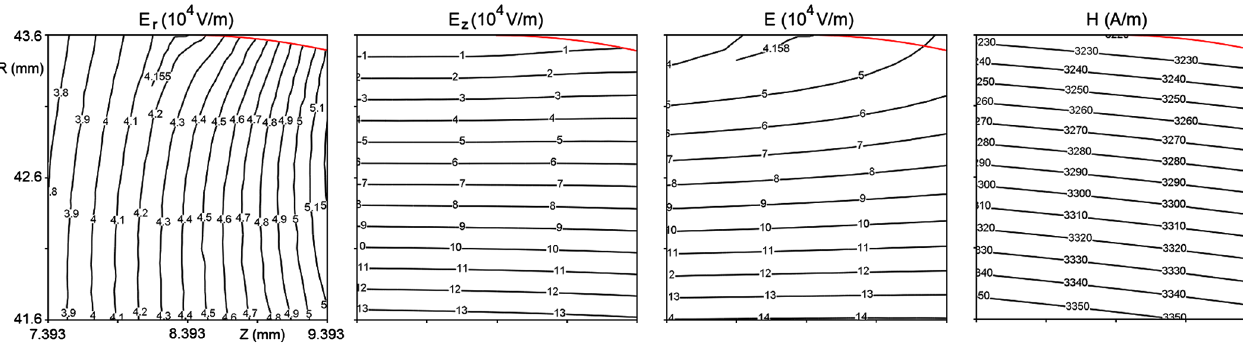
FIG. 3. Electric and magnetic fields near the MP spot of the cavity from Fig. 1. Radius of rounding of the outer cylindrical wall R ¼ 4 : 7 mm . Total energy of the field in the cavity is 1 mJ in all the